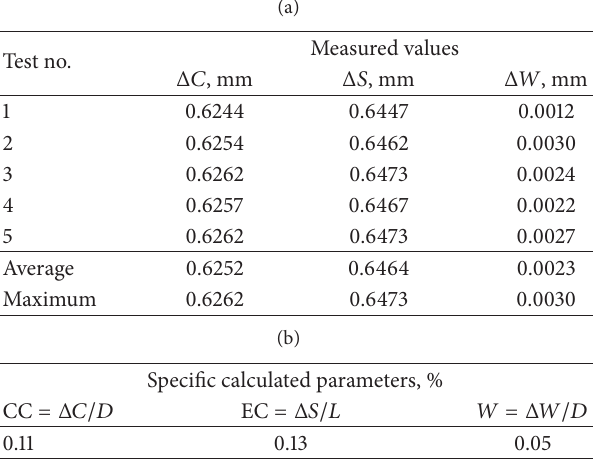
Figure 1: The position schematic of the centre points Δ𝑆 and Δ𝐶 , Δ𝑊 , and 3-point plane. Table 2: The classification results of tile first specimen.